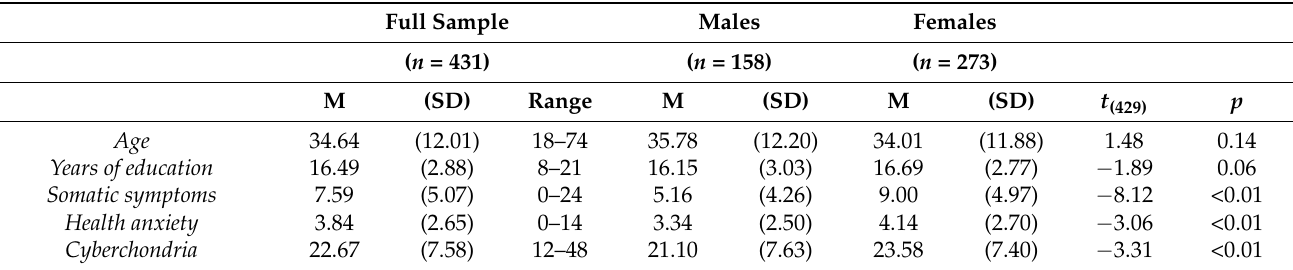
Table 1. Descriptive statistics and gender differences 1